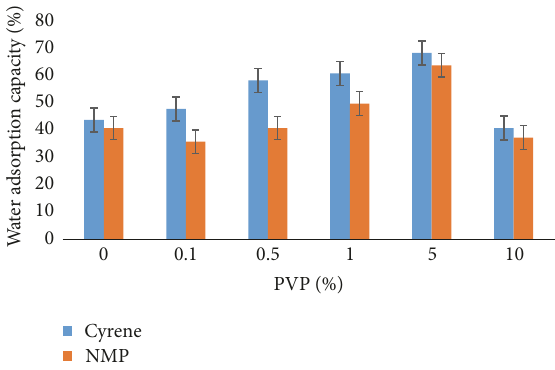
Figure 14: Gravimetric analysis of PES/C and